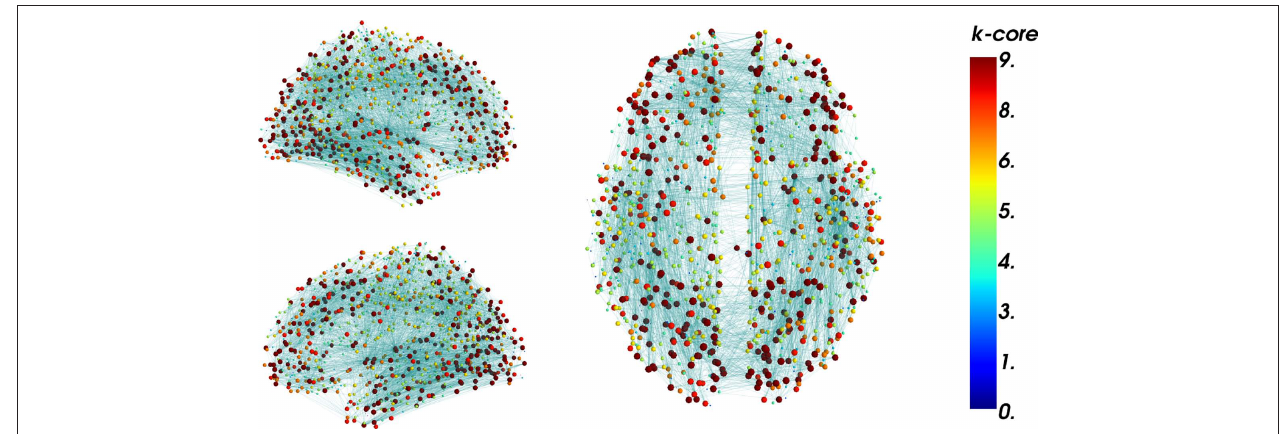
and colored according to their k-core number. The k-core number was computed using NetworkX in the IPython shell. The numbers were reused as a parameter to update the visualization interactively. Segregation of nodes with high k-core number at particular regions may be visible (Hagmann et